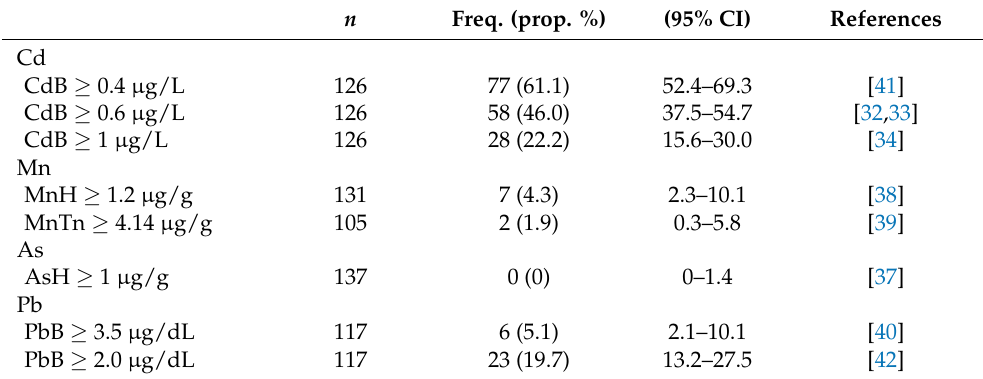
Table 2. Proportion of pregnant women with PTM levels above the references.